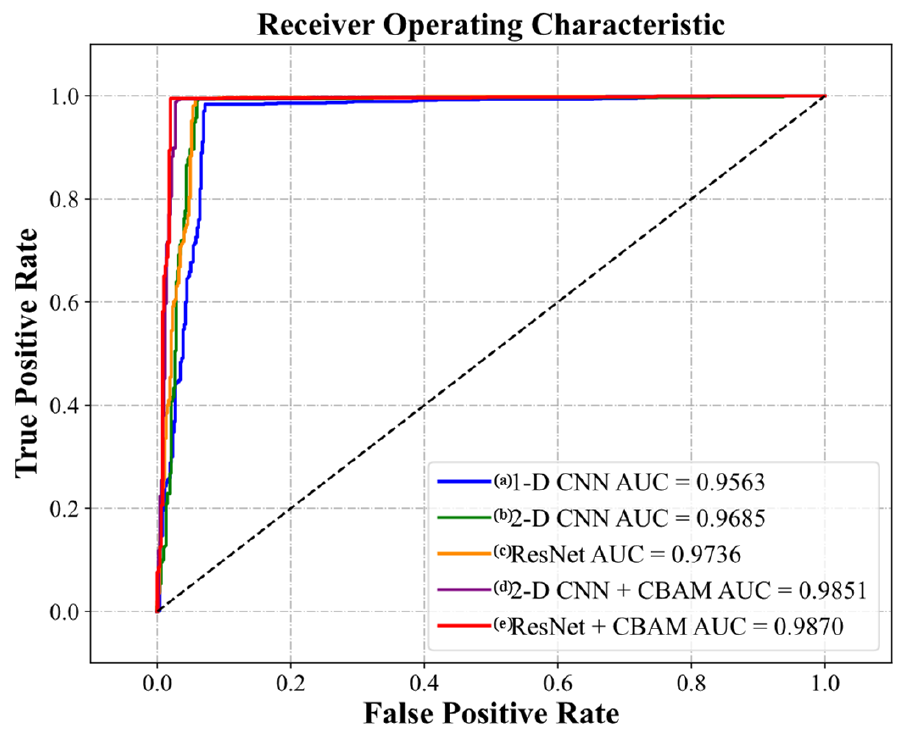
Figure 11. The ROC curves for ( a ) 1D-CNN, ( b ) 2D-CNN, ( c ) ResNet, ( d ) 2D-CNN+CBAM, and ( e ) ResNet+CBAM. Table 5. Comparison of the recognition results for the five models.